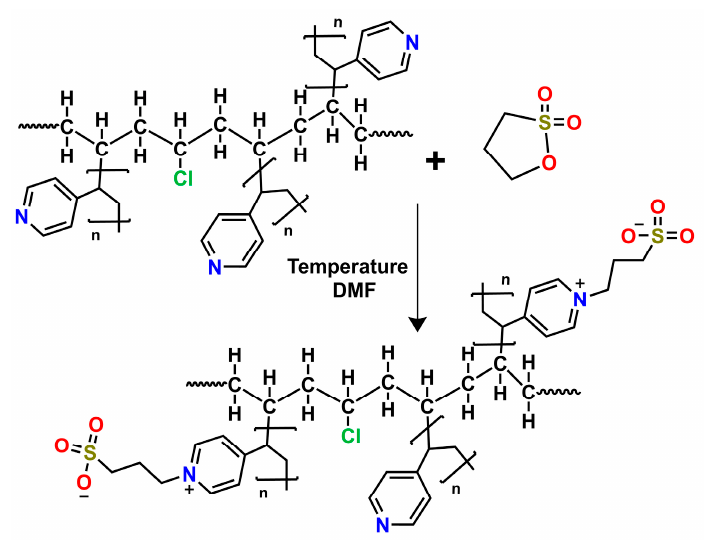
Figure 1. Reaction scheme for PVC-g-4VP/4VPSS